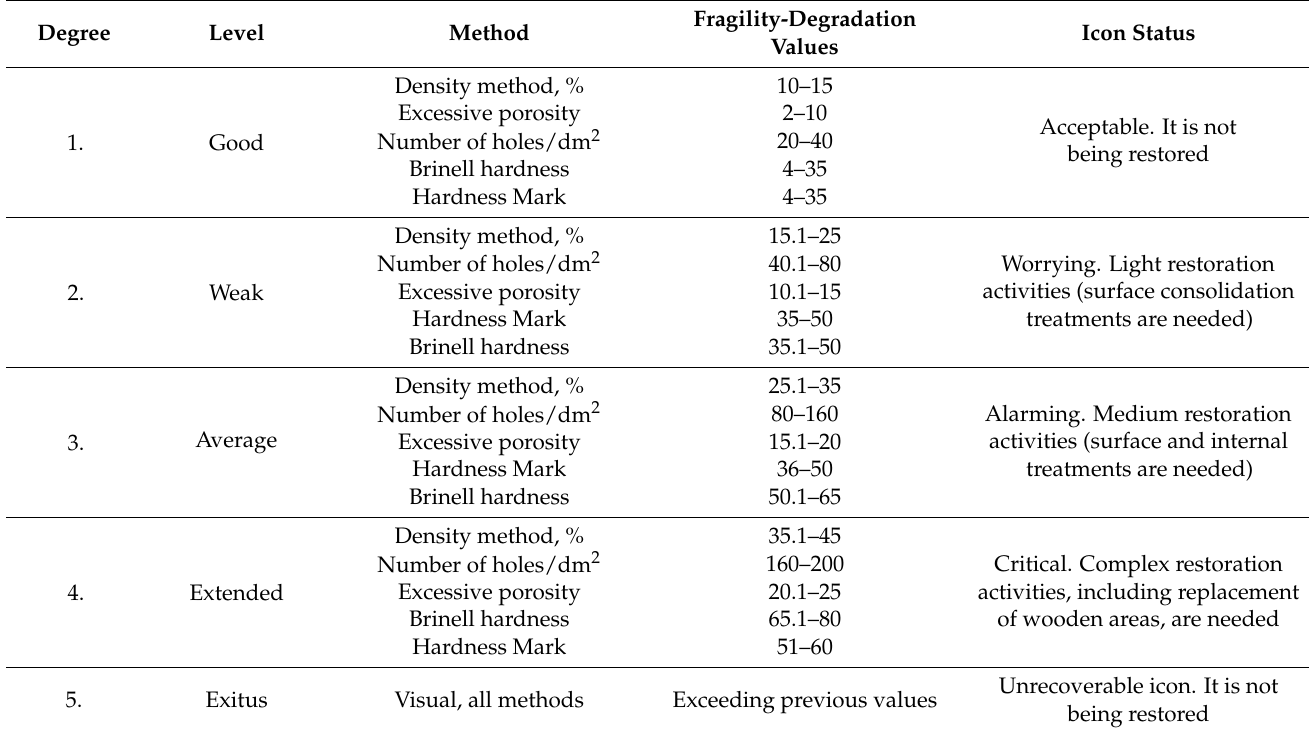
Table 5. Defining the degree and ranking level of